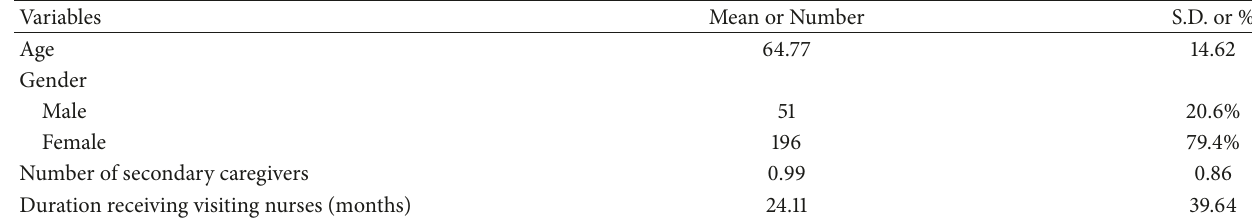
Table 1: Demographic variables of the primary